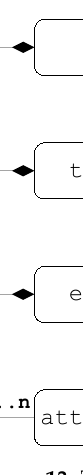
Figure 13. The simplified UML diagram of the Event